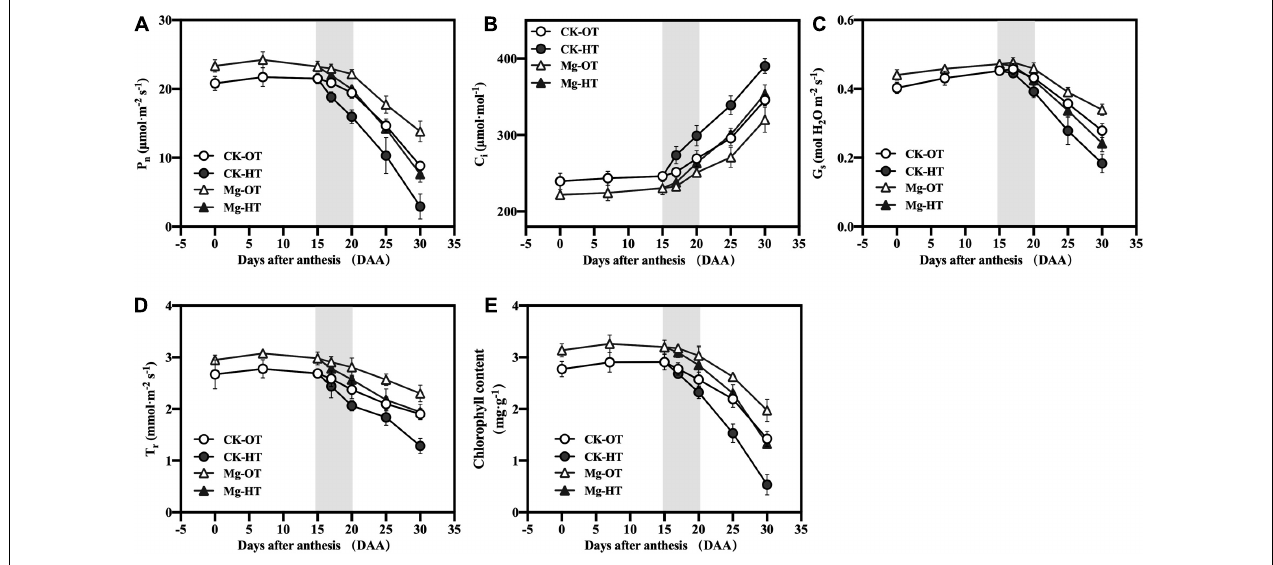
FIGURE 2 | Effect of Mg application on net photosynthesis rate (P n ) (A) , intercellular CO 2 concentration (C i ) (B) , stomatal conductance (G s ) (C) , transpiration rate (T r ) (D) , and chlorophyll content (E) under high-temperature stress during the grain filling. Vertical bars above mean indicate the SE of five replicates at P < 0.5.